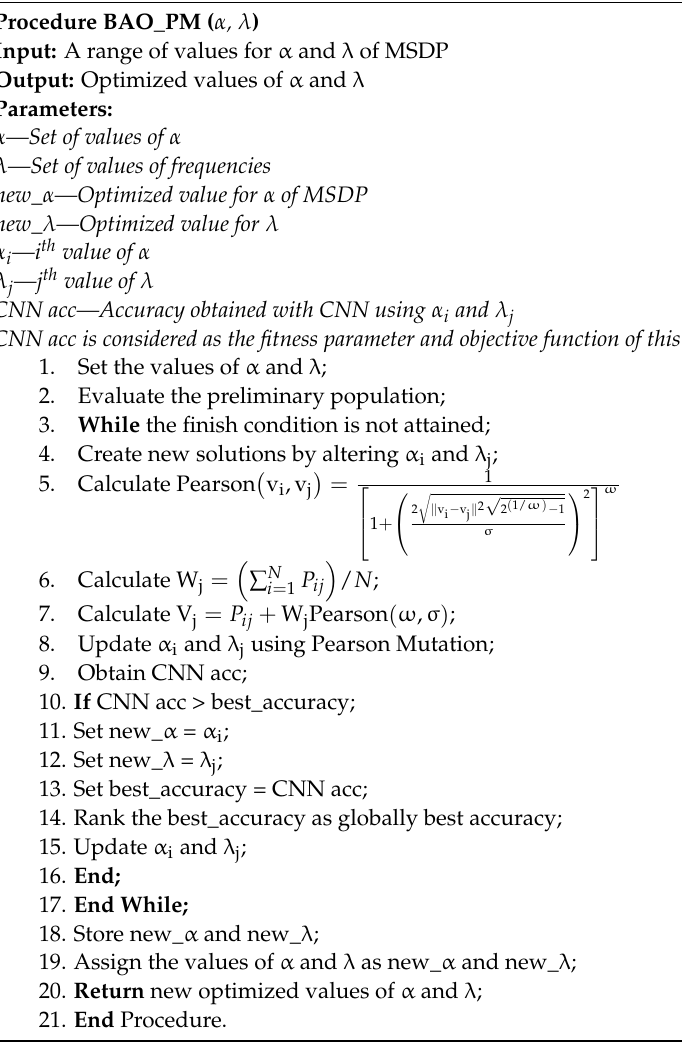
Algorithm 1 Bat algorithm-based optimization of parameters with Pearson